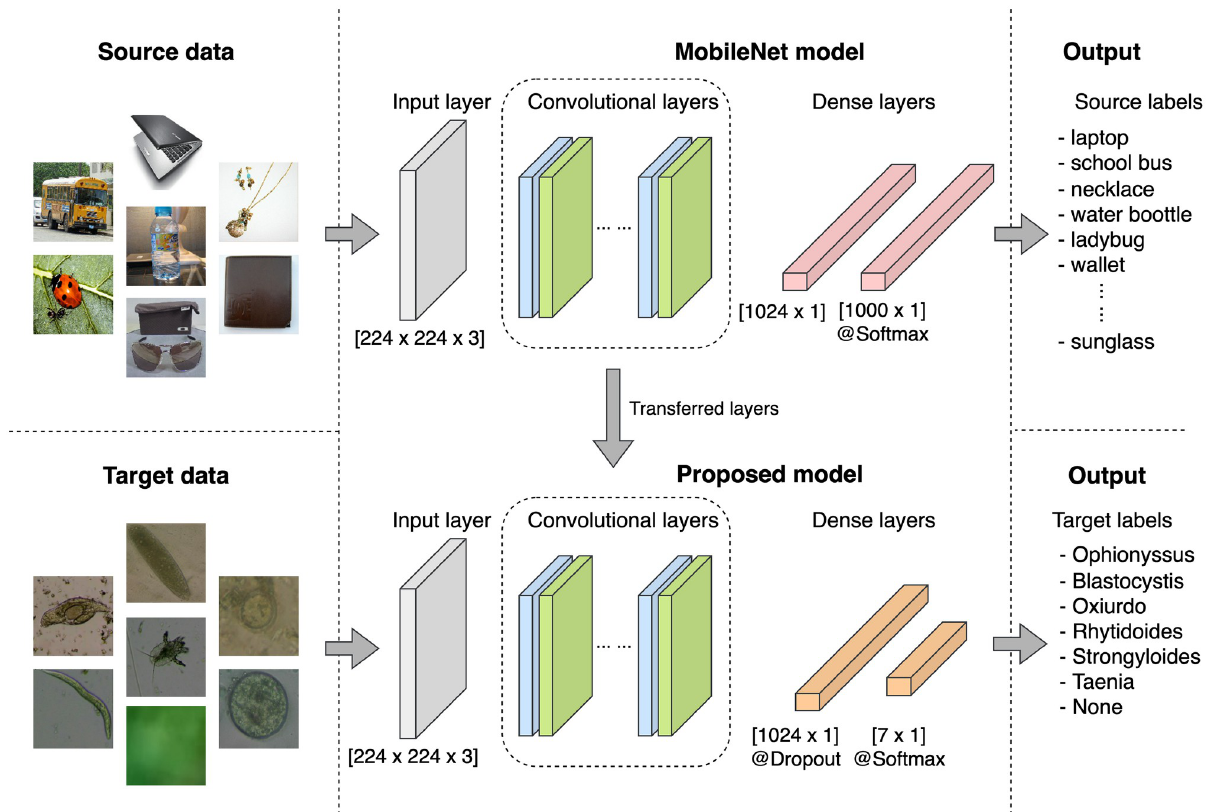
Fig 6. Workflow of the transferred learning